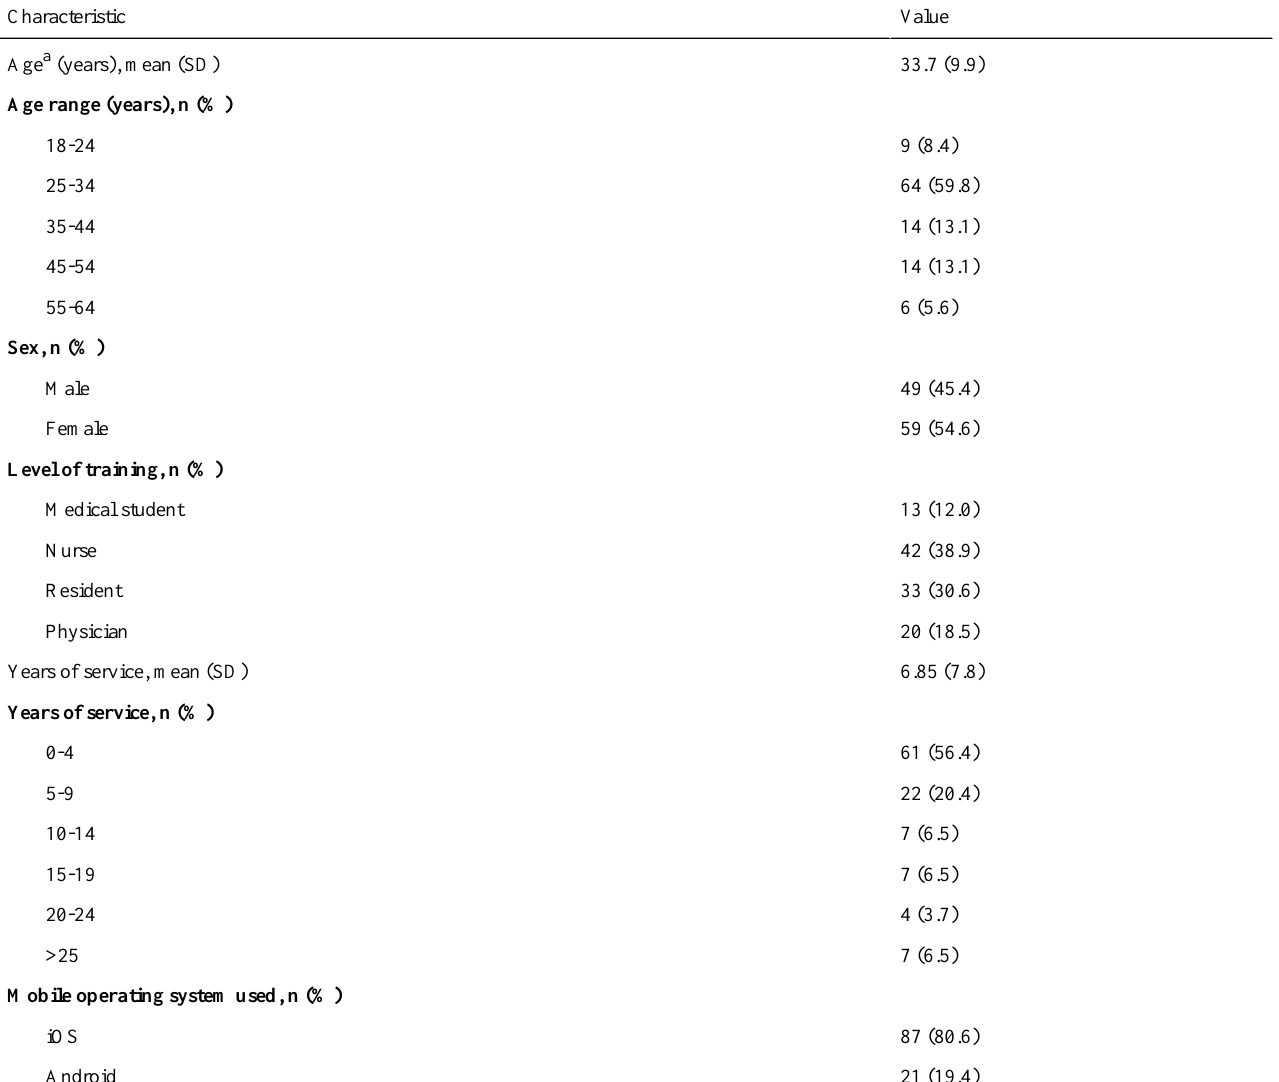
Table 1. Summary of participant characteristics (n=108).